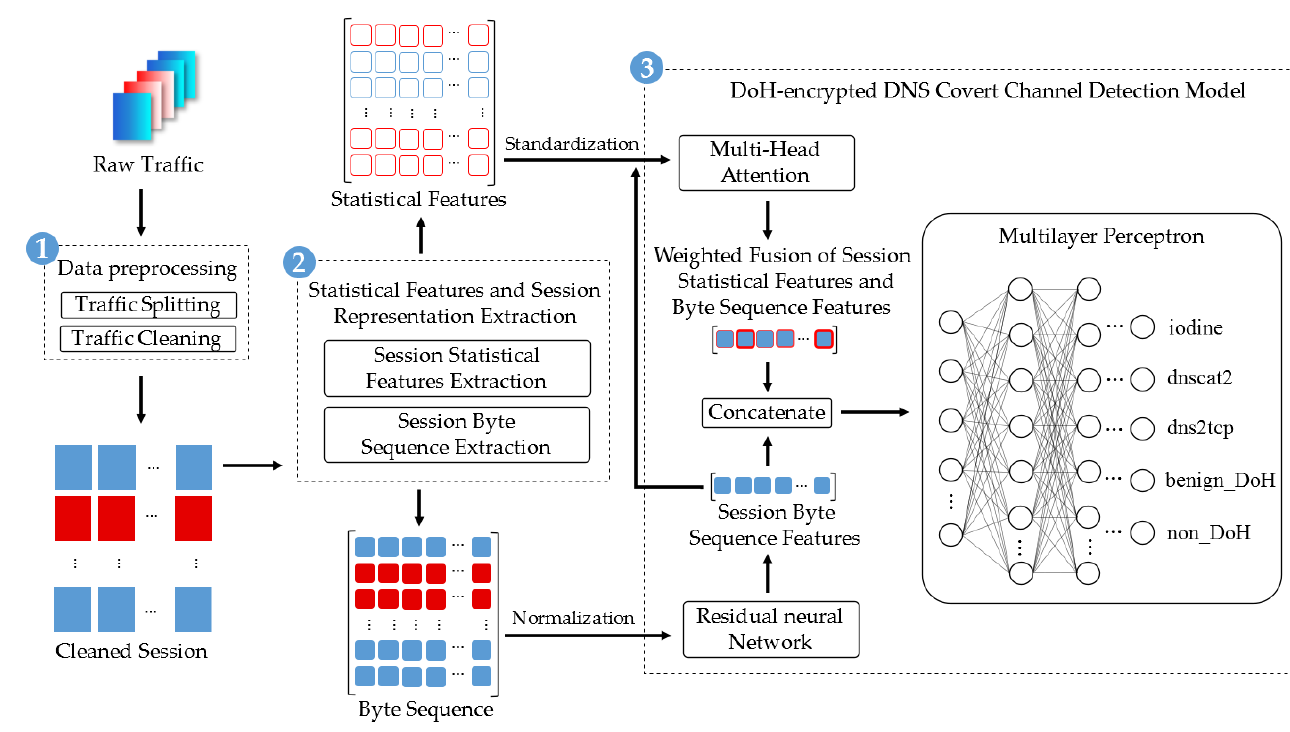
Figure 2. Framework of